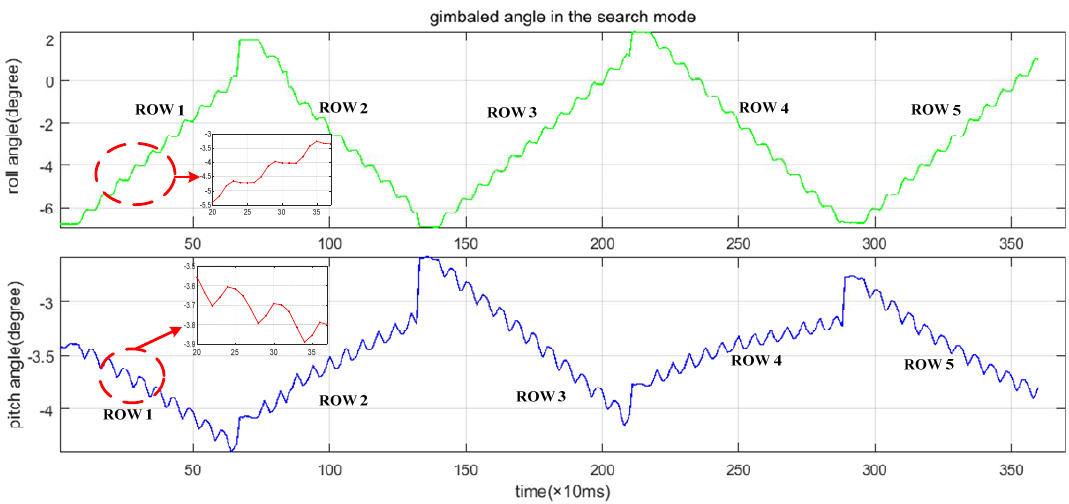
Figure 12. The gimbaled angles in search mode.